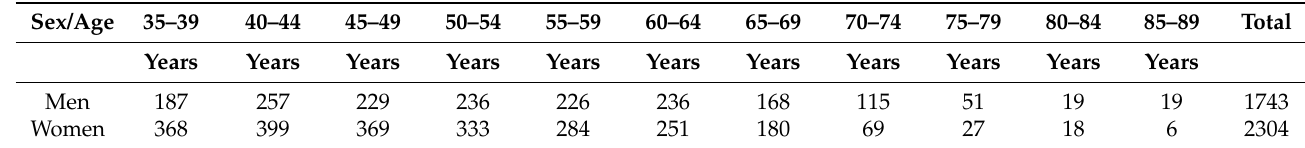
Table 1. The distribution of age and gender for all subjects in the study.